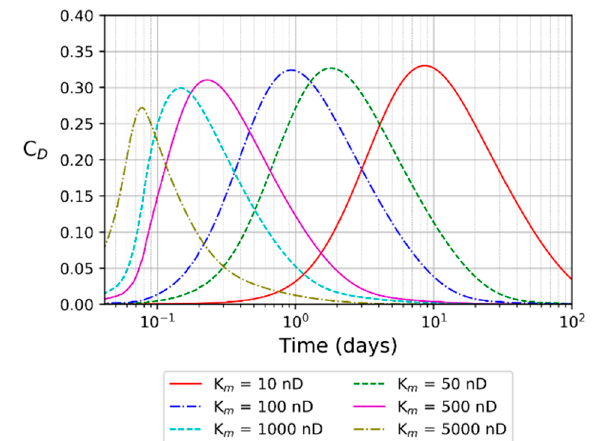
Figure 6. Tracer response curves during flowback for several reservoir permeability cases. An increase in reservoir permeability leads to an early peak and a decrease in the peak tracer concentration.